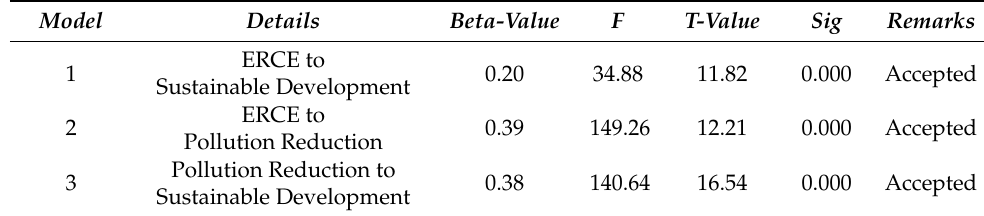
Table 4. Results of